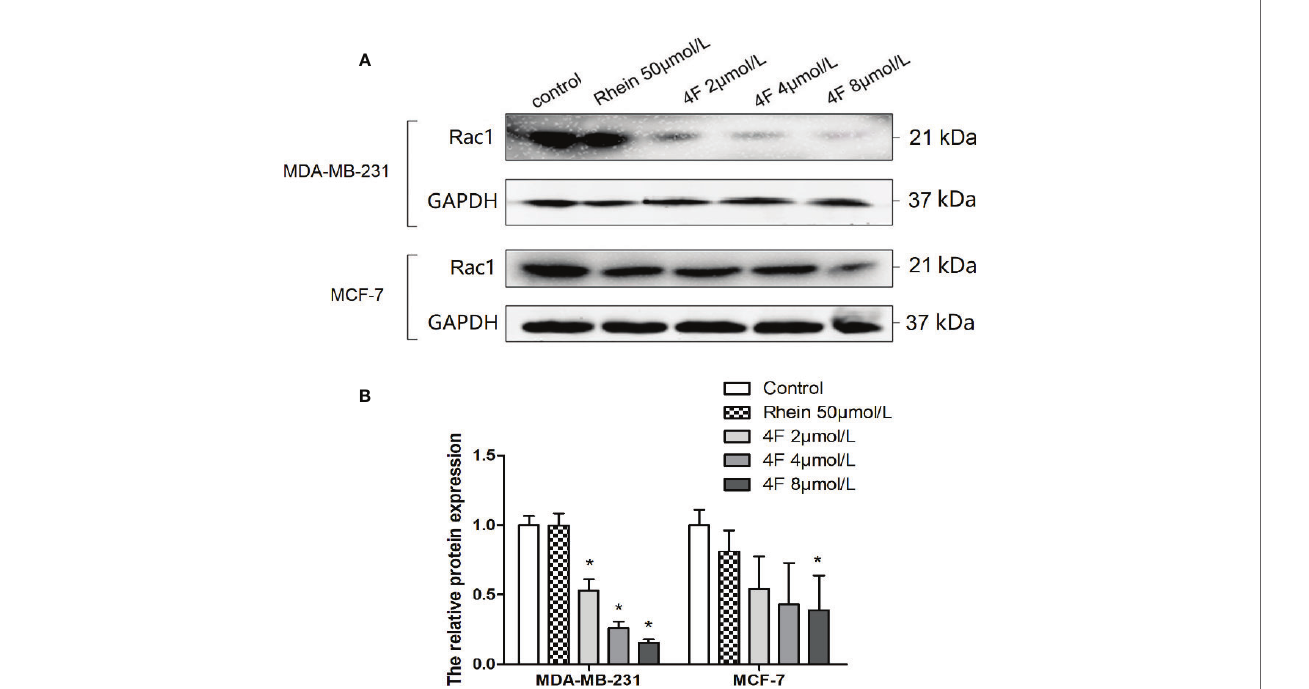
FIGURE 7 | Rac1 protein expression inhibition by Rhein and derivative 4F in breast cancer cells. (A) Western blot assay to detect Rac1 protein expression levels in MDA-MB-231 and MCF-7 cells. (B) The relative Rac1 protein expressions in MDA-MB-231 and MCF-7 cells. Rac1 expression (normalized against GAPDH) in the control groups was considered to be 100% in these two cell lines. Data are shown as means ± SD (n = 3). One-way analysis of variance (ANOVA) was used for statistical analysis. * P < 0.05, comparison of each treated group and control